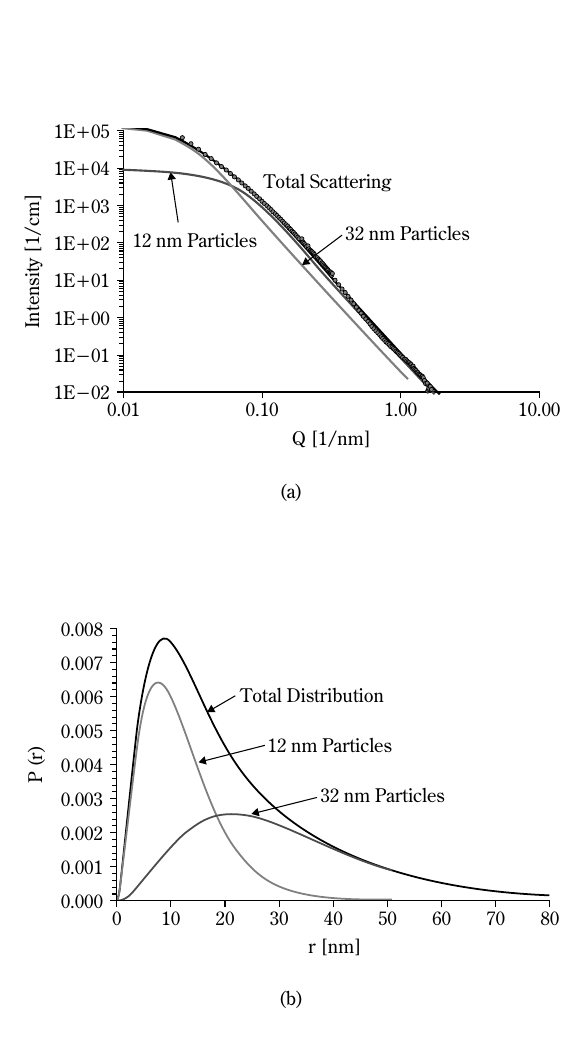
Fig. 5 SANS results confirming the existence of a bimodal distri- bution of crystallites in the nano Fe: (a) overall scattering data and (b) relative distributions of the particle